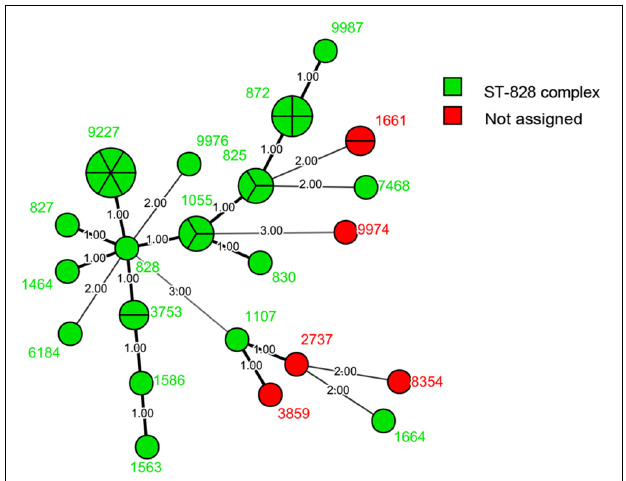
FIGURE 2 | Phylogenetic analysis. Minimum spanning tree (MST) of MLST data of 36 C. coli human isolates collected in 2017 and 2018 in Beijing, China. Green represents the ST-828 complex and red represents isolates that do not belong to any known clonal complex. Isolates are represented by circles, and the size of the circle is proportional to the number of isolates. Branches and numbers represent allelic differences between isolates.